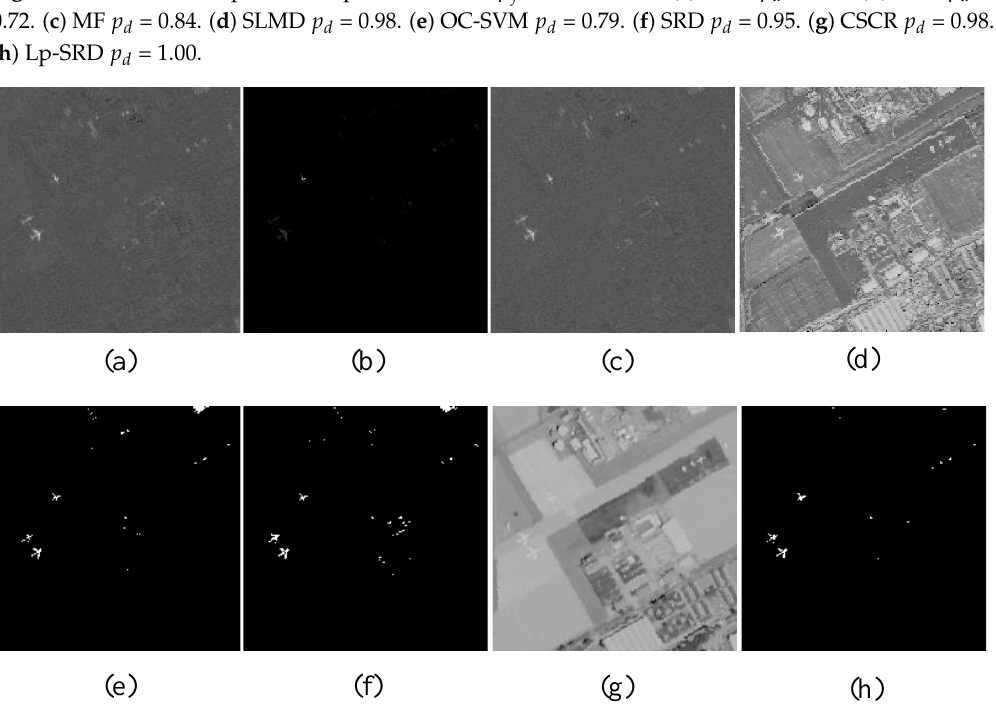
Figure 15. Detection maps for the San Diego dataset p f is fixed to 0.1: ( a ) CEM p d = 0.85. ( b ) ACE p d = 0.72. ( c ) MF p d = 0.80. ( d ) SLMD p d = 0.52. ( e ) OC-SVM p d = 0.90. ( f ) SRD p d = 0.73. ( g ) CSCR p d = 0.92. ( h ) Lp-SRD p d =